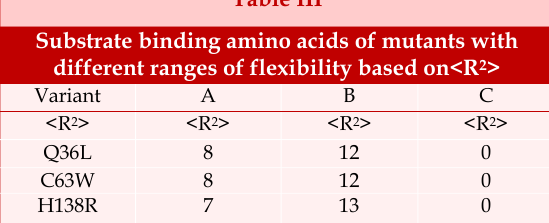
Substrate binding amino acids of mutants